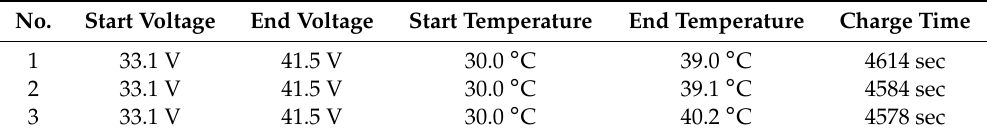
Table 5. Experimental results by CC charging